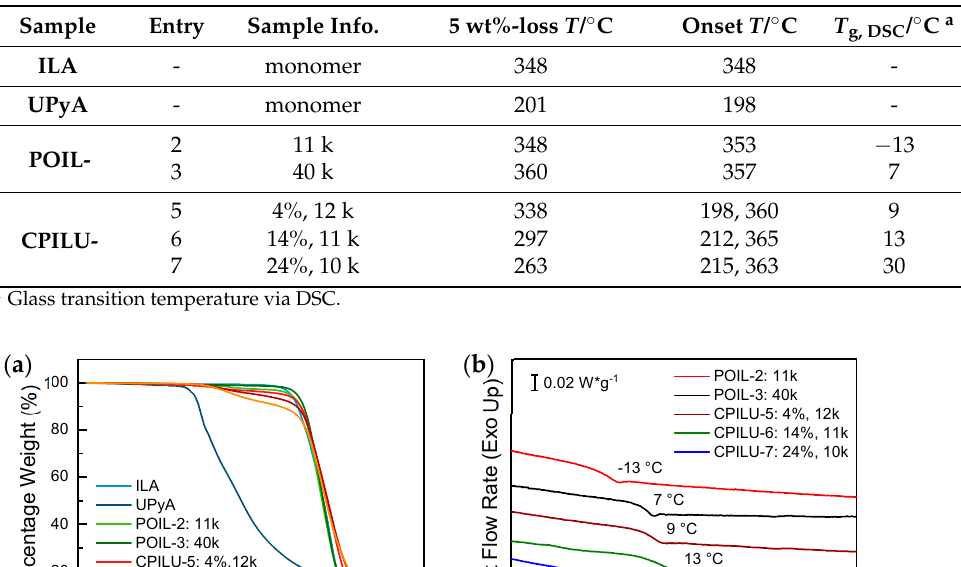
Table 3. Thermal characterization data of ILA , UPyA , POIL-x , and CPILU-y via thermogravimetric analysis and differential scanning calorimetry.